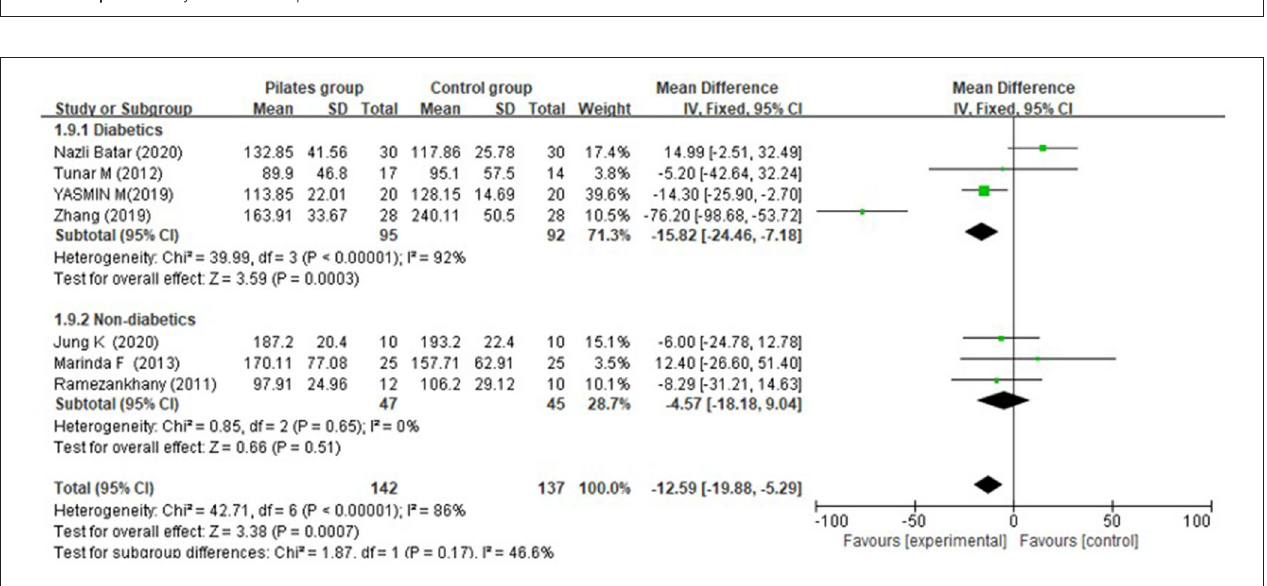
FIGURE 8 | Meta-analysis and forest plot for